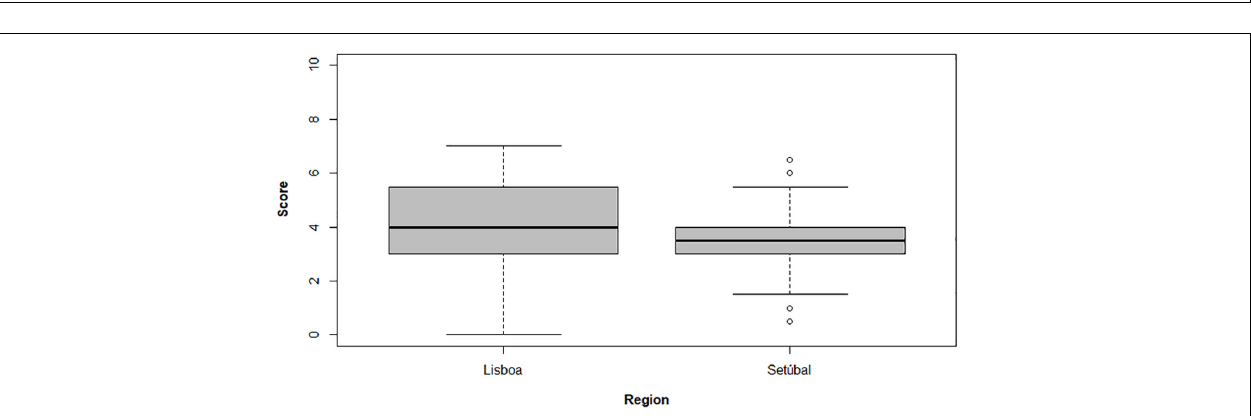
FIGURE 3 | Posttest scores considering the type of school (private and public) [Middle line – median; box lower and upper limits – 1st and 3rd quantiles; whisker values – 1.5 times the interquartile range from the top (or bottom) of the box to the furthest datum; points – outliers].